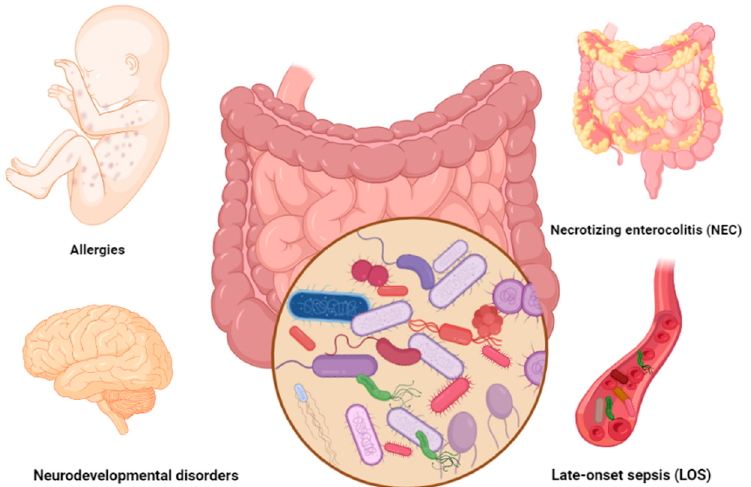
Figure 1. Common gut-microbiota-associated complications in preterm infants. Figuresin this manuscript were created specifically for this manuscript in BioRender.com, accessed on 15 August